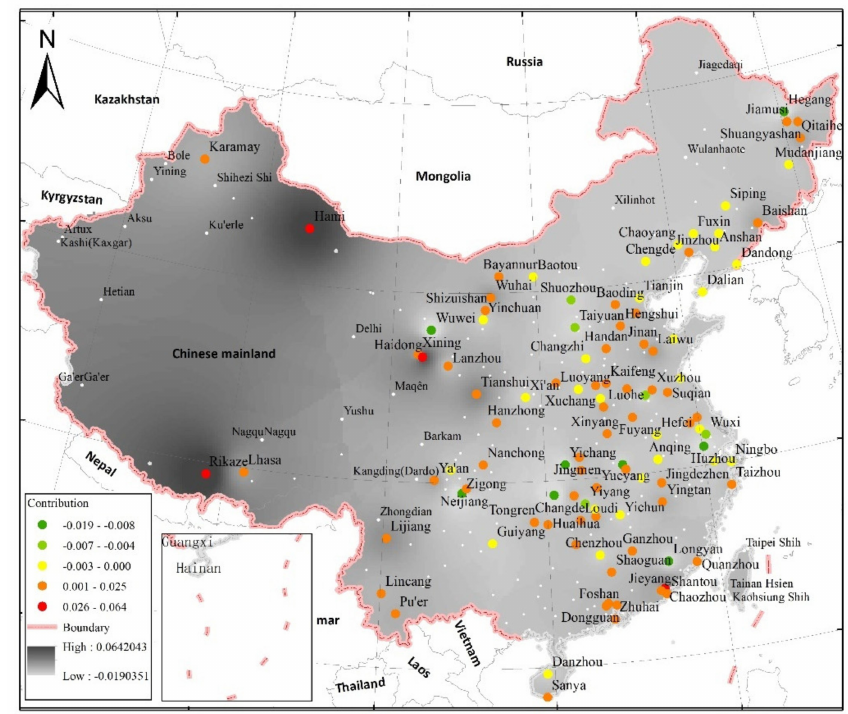
Figure A3. Contribution from the indicator GRPC (gross regional product of the city) to land-use intensity revealed in the city-based